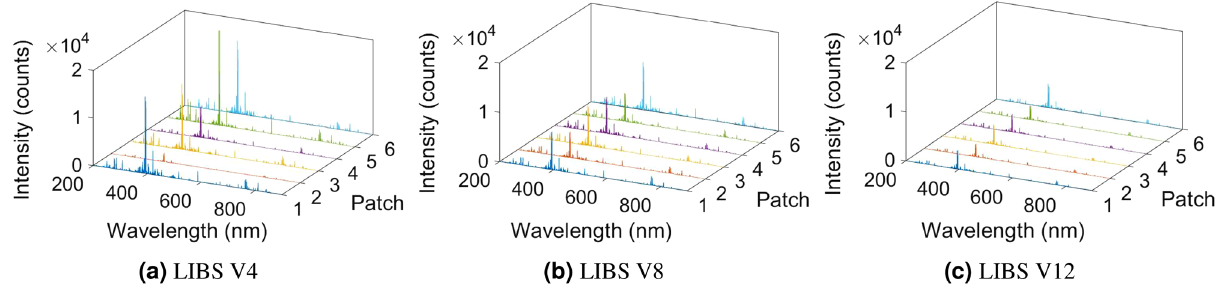
Figure 2. Emission lines of soil samples at the V4, V8, and V12 stages for six